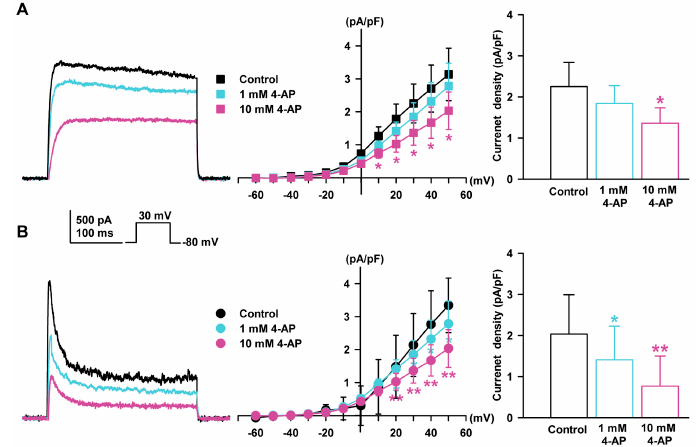
Figure 2. Effect of 4-aminopyridine (4-AP) on K V currents in HCFs. ( A ) The representative rapid activated and slow inactivated, I K recorded in a single HCF in control conditions and after application of 4-AP (1 or 10 mM). The current-voltage ( I-V ) relationship of steady-state currents with I K changed in the presence of 4-AP, and the concentration-response bar graphs for the 4-AP effect on I K are shown. ( B ) Typical rapid-activated and inactivated I to in control and after 4-AP (1 or 10 mM) addition. The I-V relationship of peak currents changed by the presence of 4-AP on I to and concentration-response bar graphs are shown. * p < 0.05, ** p < 0.01 versus the control.